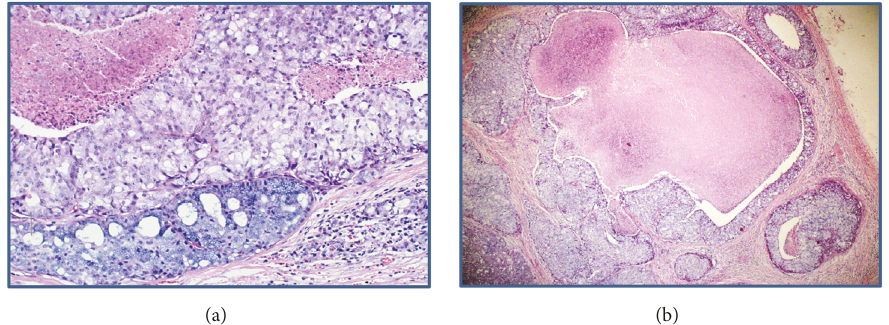
Figure 1: (a) Hematoxylin and eosin stain illustrating a low-grade acinic cell carcinoma at the bottom juxtaposed to a high-grade carcinoma, simulating a salivary duct carcinoma with central necrosis. (b) An area of high-grade transformation demonstrating an infiltrating tumor with extensive central necrosis.